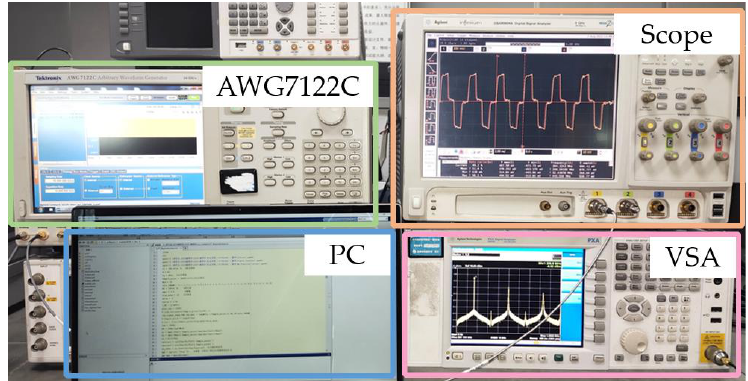
Figure 10. Off-line experimental platform diagram.